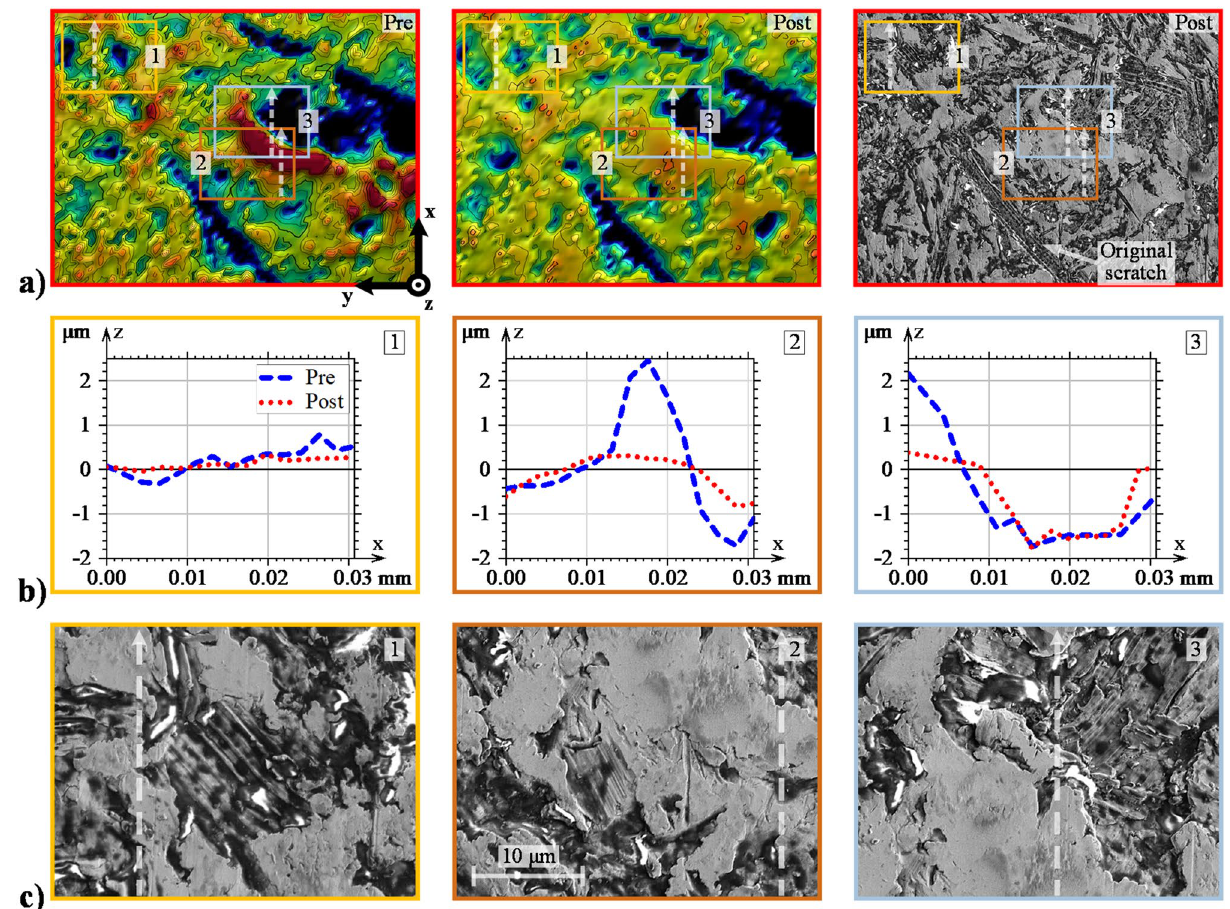
Figure 4. Detailed evaluation of the load-derived asperities: ( a ) enlarged view of area II in Fig. 2, ( b ) 2D profiles of prominent asperities taken in the direction of sliding, and ( c ) SEM analysis of the corresponding